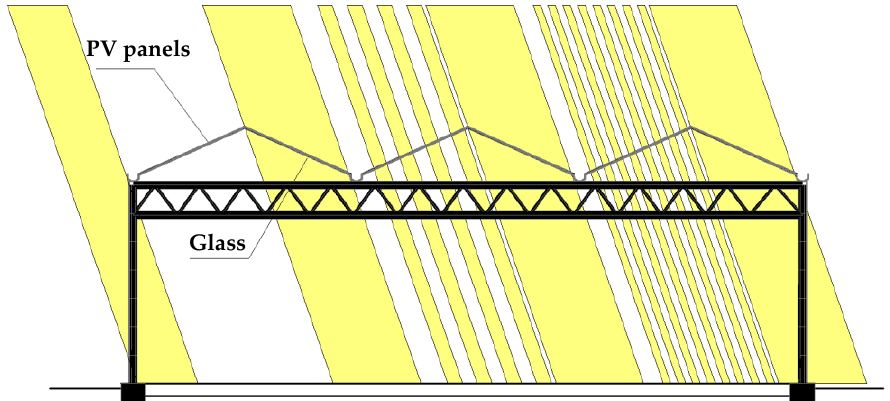
Figure 5. Direct solar radiation at Mediterranean latitudes for a different checkerboard formation of photovoltaic panels: 21 June, 12:00 pm.